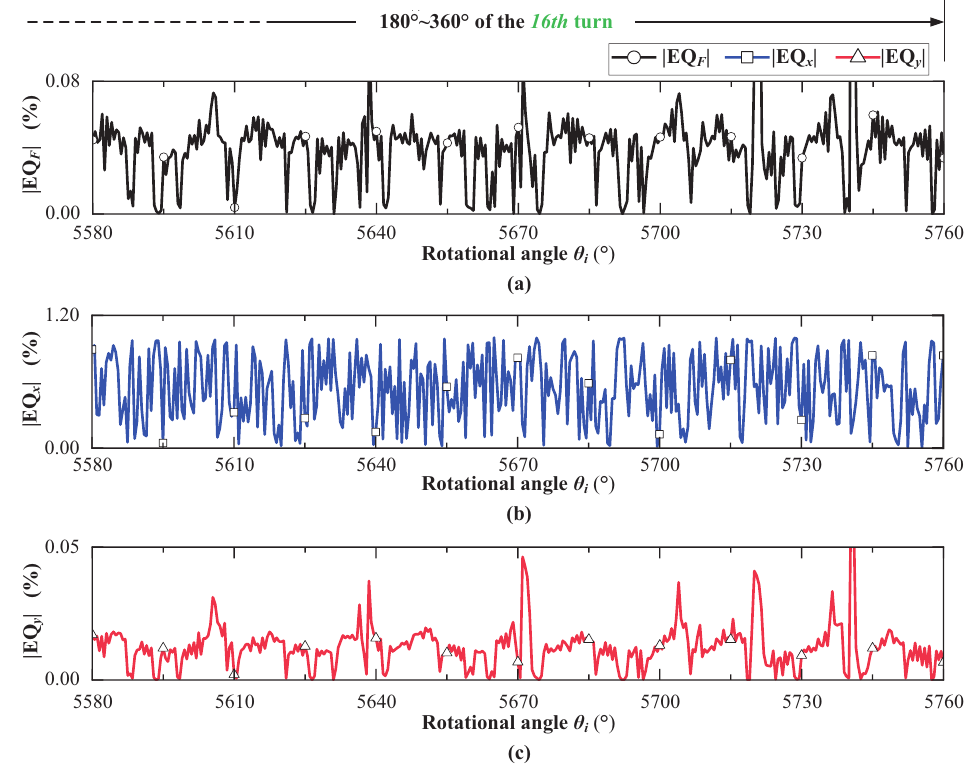
Figure 14. Oil film force balance error test results. ( a ) Oil film axial force error. ( b ) Moment error in the direction of the x A axis. ( c ) Moment error in the direction of the y A